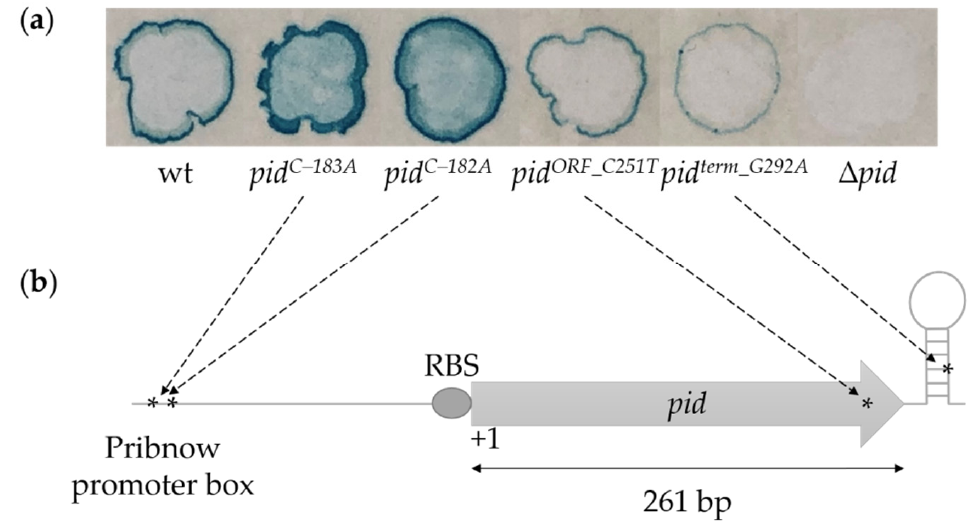
Figure 1. DES-mutagenesis screen revealed functional mutations in the P22 pid locus. Selected DES-mutagenized P22 clones plaqued on a lawn of the LT2K7 indicator (LT2 dgoT ::Mu d K) on LB X-Gal in which blue coloration reports on LacZ activity (panel ( a )) and the corresponding mutation in the pid locus (panel ( b )). Numbering of the mutations (indicated as *) is relative to the pid start codon.